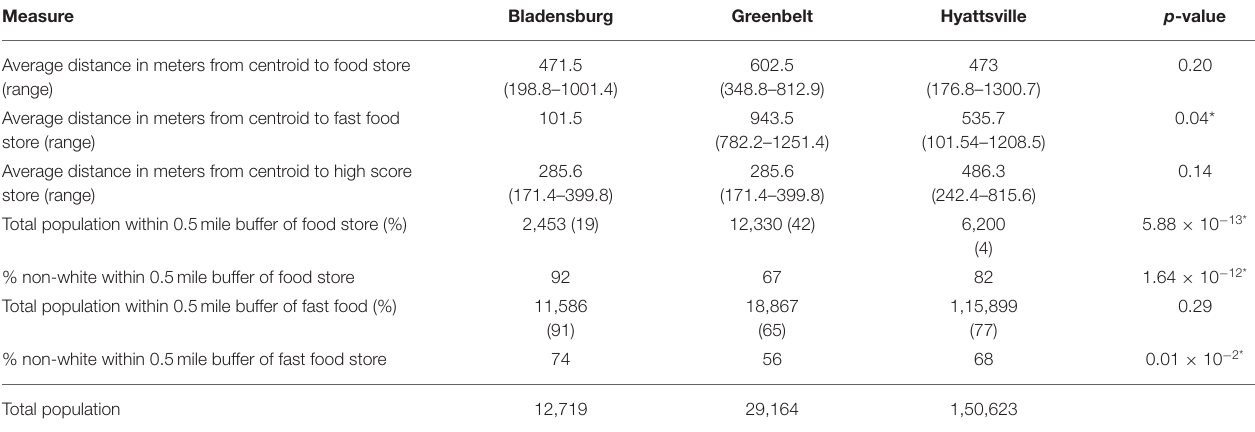
TABLE 4 | Community comparison of distance analysis, population and percent non-white population within a half-mile of a fast food store outlet or food store. Measure Bladensburg Greenbelt Hyattsville p